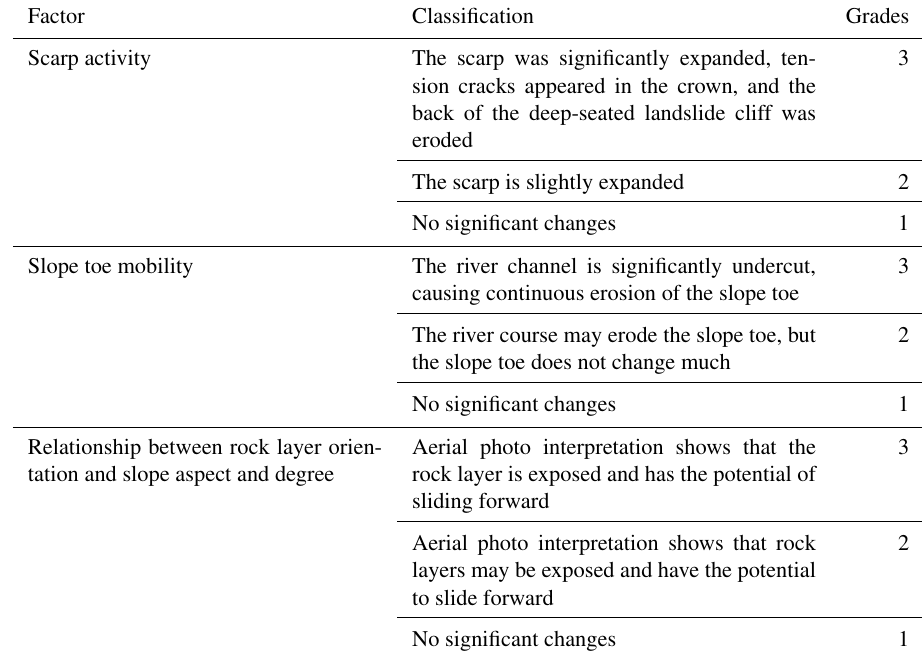
Table 3. Activity grades including dip slope features (referred to as Activity 1) (modified from Lin, 2017).